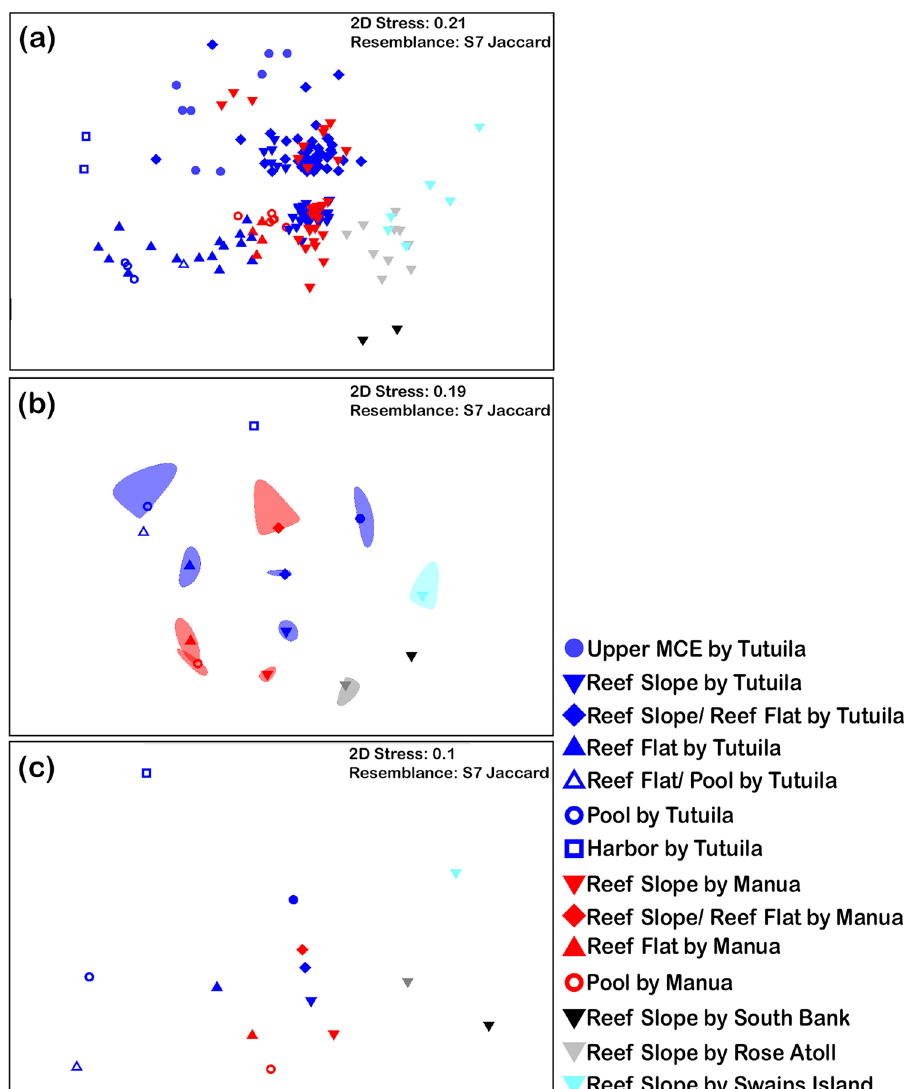
Figure 7. NMDS graphs showing coral community similarity calculated by ( a ) individual sites, ( b ) bootstrap averages for habitat groups, and ( c ) distance to centroids for habitat groups. Islands are represented by the same color and habitat groups are represented by the same